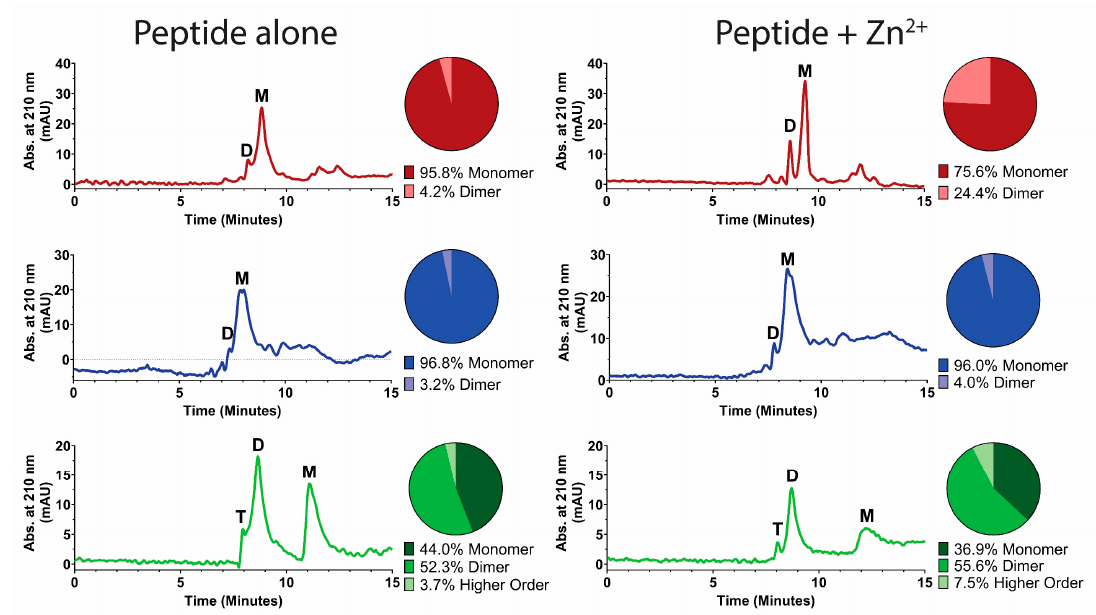
Figure 7. Zinc binding by Hst 5 promotes zinc-induced soluble dimers. Size-exclusion high- performance liquid chromatography (HPLC) was performed with protein detection at A210 to determine dimerization state of (top, red) Hst 5, (middle, blue) Hst 5 Δ MB, and (bottom, green) P113 at a concentration of 329.34 µM in mobile phase composed of either zinc-free 10 mM sodium phosphate buffer pH 7.4, or buffer with added zinc at a concentration of 164.67 µM. Each condition was run in triplicate. Peak identification was made based upon comparison to known standards and area under the curve of peaks was used to calculate the relative percentage of peptide in monomer (M), dimer (D), and higher order oligomer (T) form (circle graphs). Representative traces of individual runs were subjected to second order smoothing for visualization.